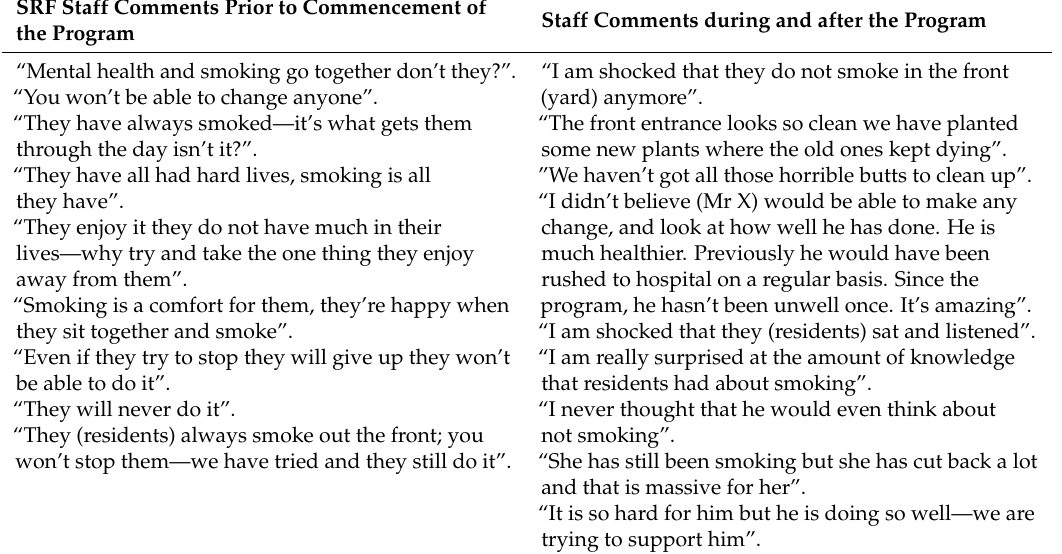
Table 2. Comparison of SRF staff